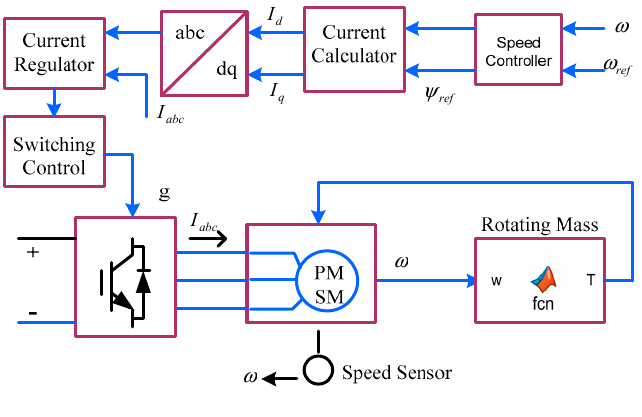
Figure 7. Flywheel model.